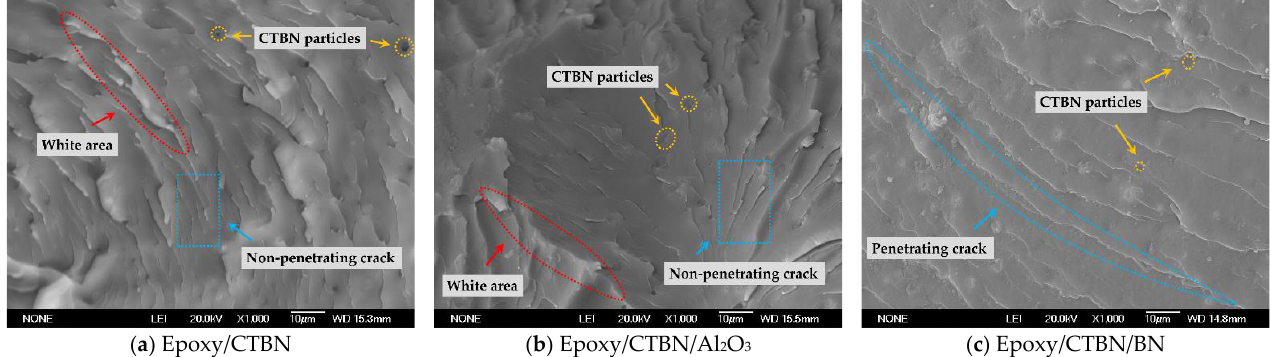
Figure 1. SEM photographs of three kinds of composites system. ( a ) Epoxy/CTBN; ( b ) Epoxy/CTBN/Al 2 O 3 ; ( c ) Epoxy/CTBN/BN.